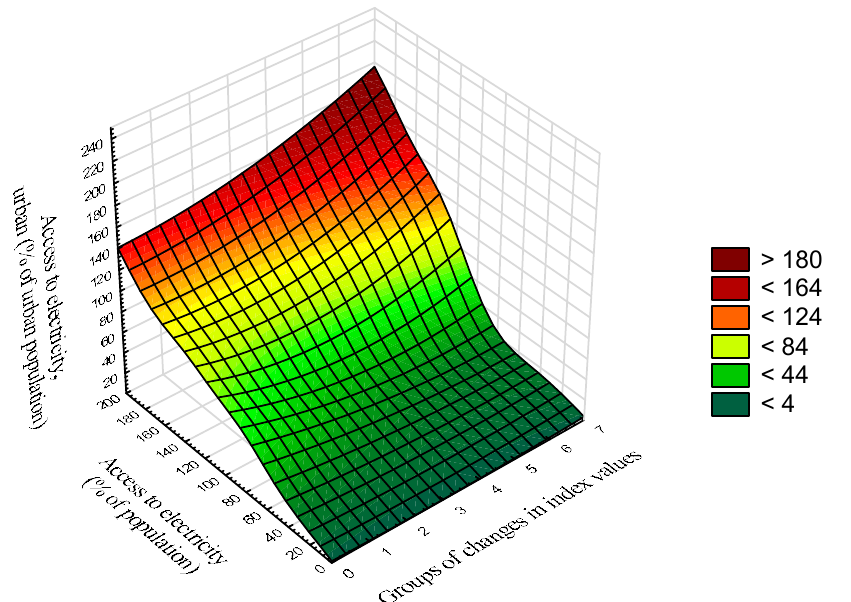
Figure 8. Distribution of the values of indicators for access to clean fuels and technologies for cooking (% of population) and renewable energy consumption (% of total final energy consumption) in relation to the classification by changes in the values of all indicators from 2000 to 2019. Source: own